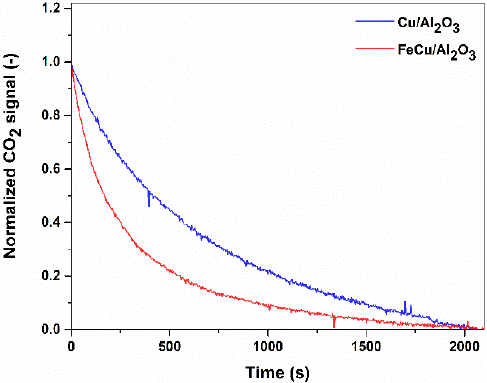
Figure 5. Transient CO reduction of the oxidized catalyst after treatment in O 2 . Reaction conditions: W cat = 0.3 g, F tot = 100 mL/min, P CO = 0.02 bar, T = 250 °C.